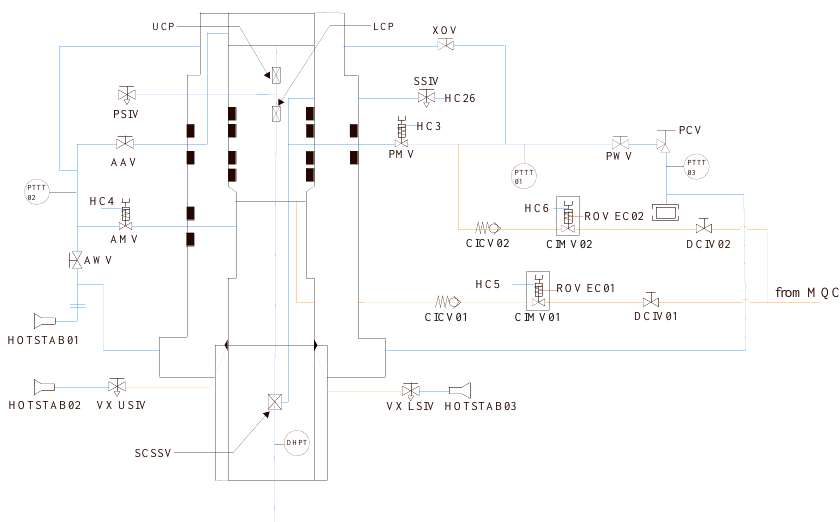
Figure 6. Layout of valves and instruments of the control system located in the tree and